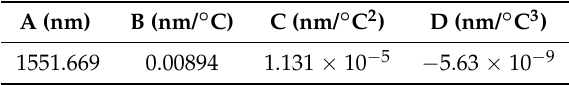
Table 1. Specifications of the GF1B fibre